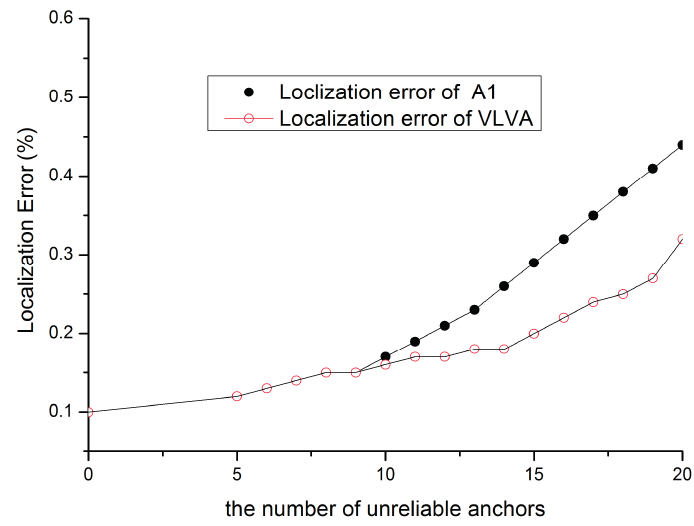
Figure 10. Performance of re-localization.